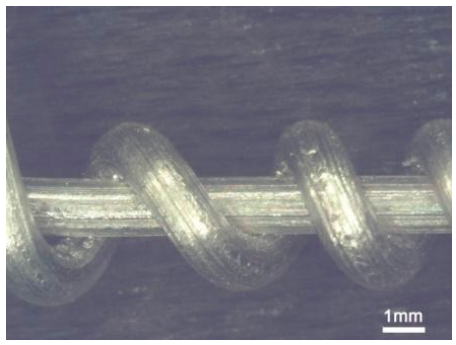
Figure 7. 0.50 wt.% MoB 2 .